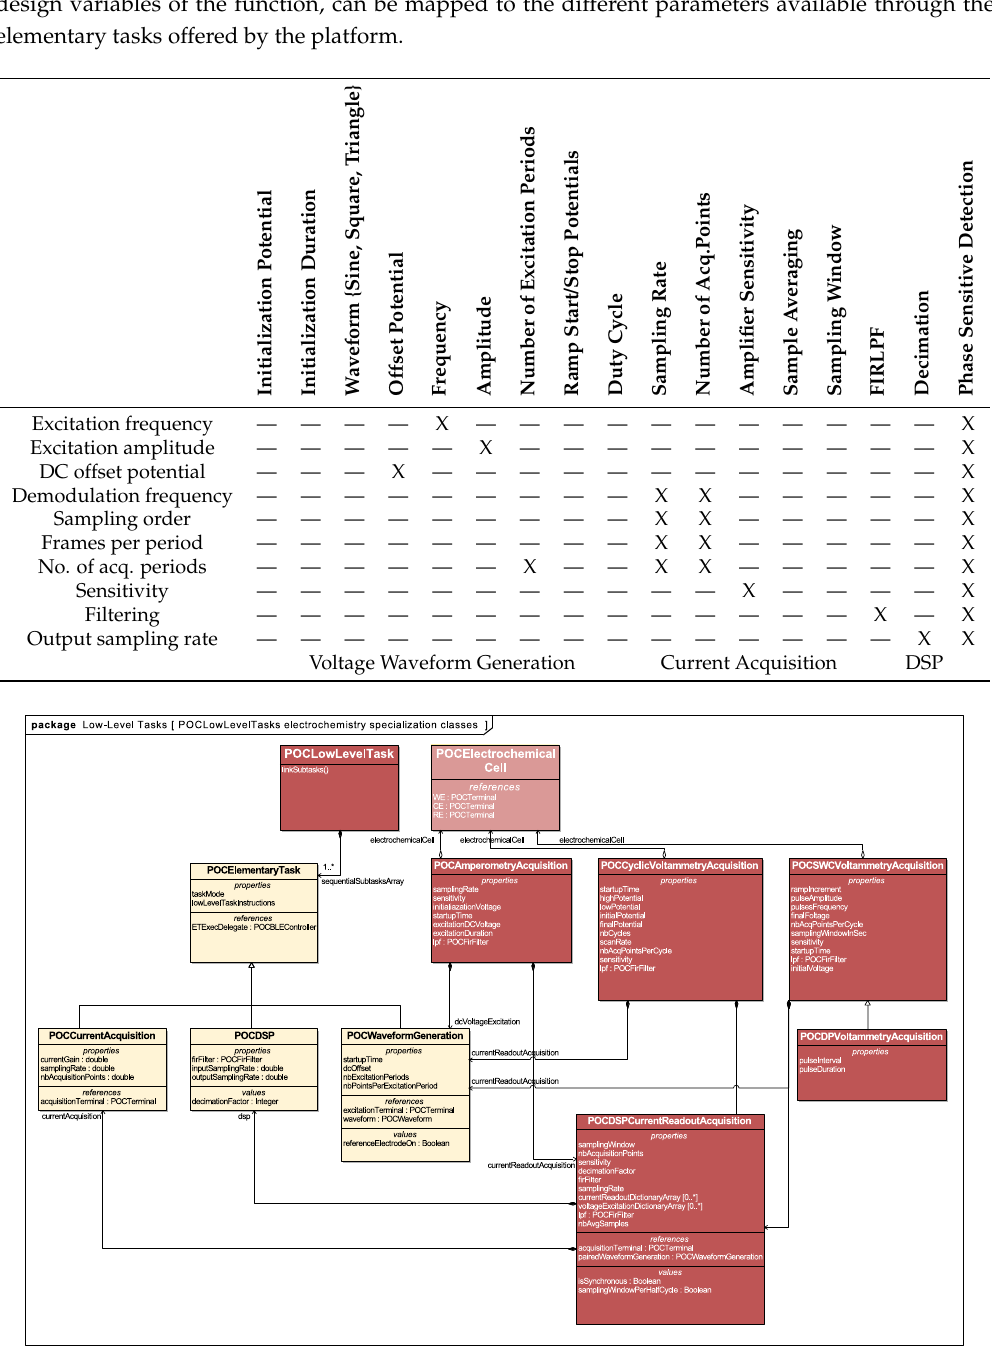
Figure 4. Electrochemical analysis acquisition LLTs’